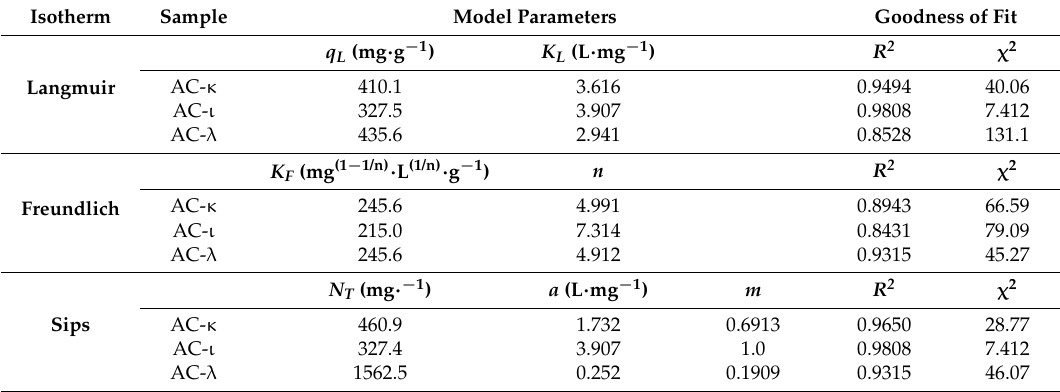
Table 3. Equilibrium model parameters and goodness of